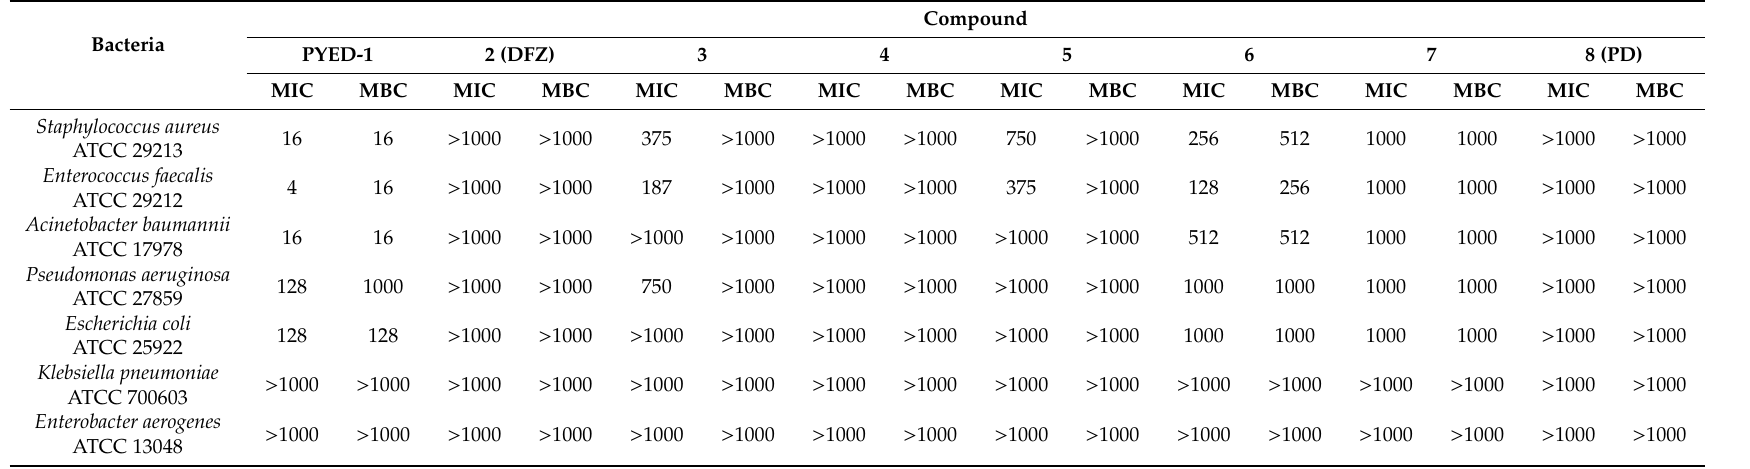
Table 2. Minimum inhibitory concentration (MIC) ( µ g / mL) and minimum bactericidal concentration (MBC) ( µ g / mL) values of PD, DFZ and its precursors against a panel of Gram-negative and Gram-positive